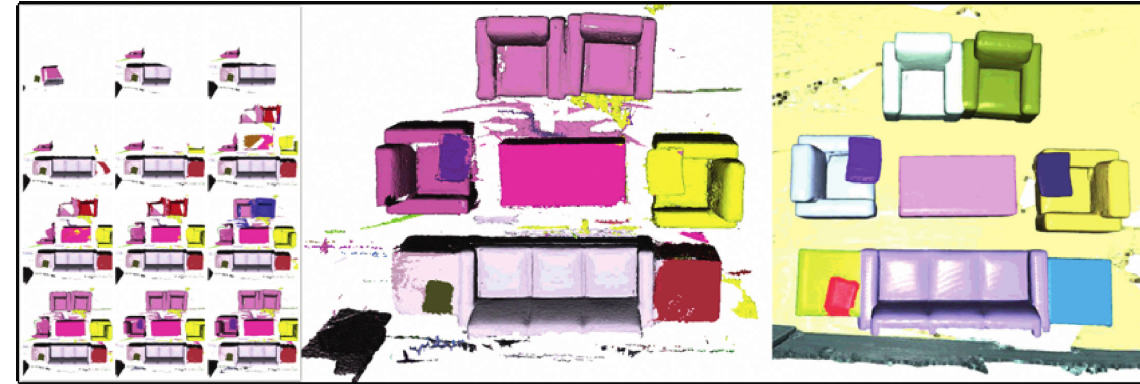
Figure 4: Generation process of incremental instance-oriented semantic mapping in real time.